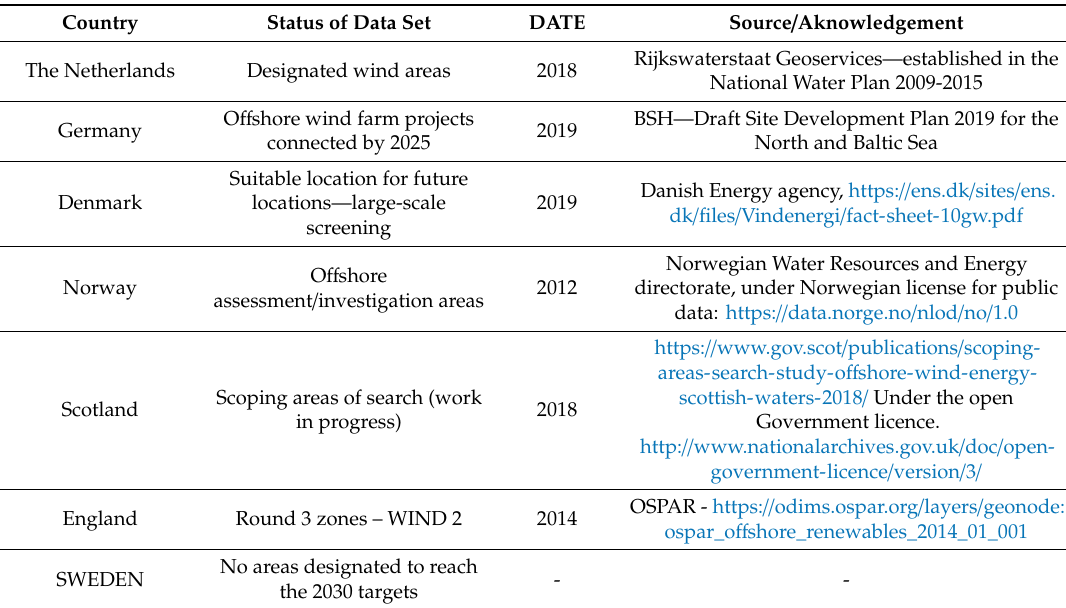
Table 2. O ff shore wind farm development areas designated for meeting the 2025–2030 energy